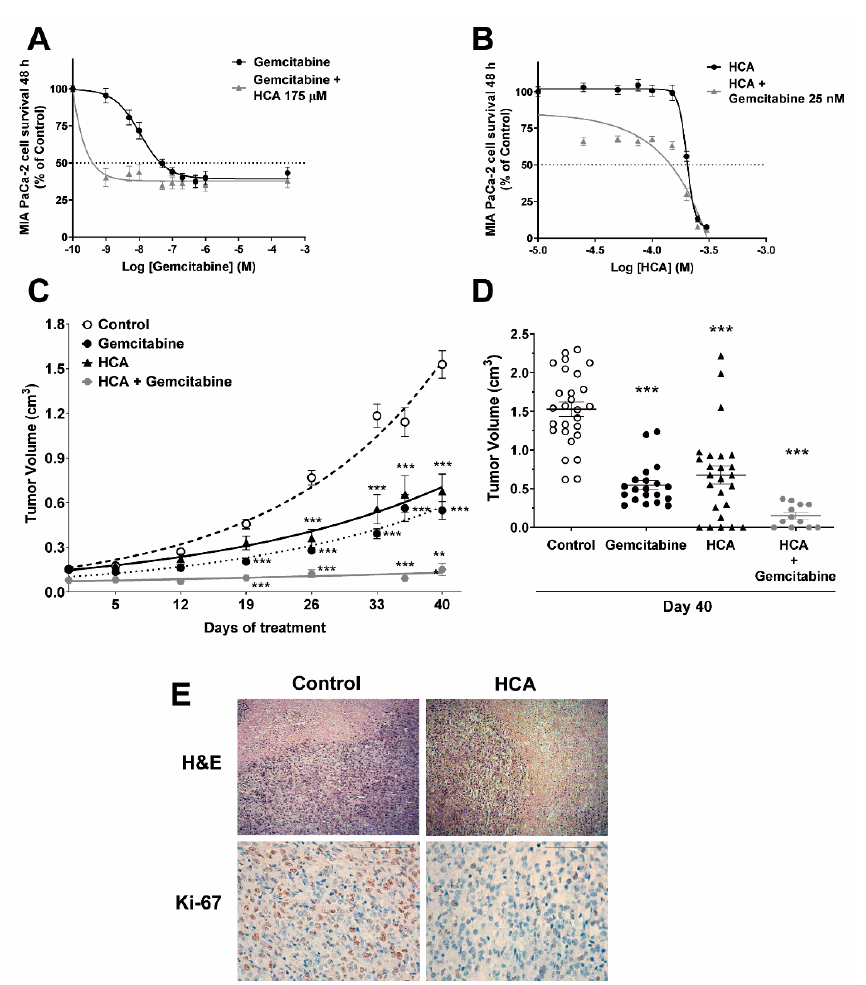
Figure 1. Efficacy of HCA against pancreatic cancer. ( A ) Concentration-dependent inhibition of human pancreatic cell (MIA PaCa-2) growth by gemcitabine and gemcitabine in combination with HCA (175 µM) over 48 h. ( B ) Concentration-dependent inhibition of human pancreatic cell (MIA PaCa-2) growth by HCA and HCA in combination with gemcitabine (25 nM) for 48 h (mean ± SEM from 3 independent experiments performed in quadruplet). ( C ) Effects of the vehicle alone (control), gemcitabine (100 mg/kg, i.p., twice weekly), HCA (200 mg/kg, p.o., daily), or HCA + gemcitabine (100 mg/kg, p.o., daily + 100 mg/kg, i.p., once weekly) on MIA PaCa-2-derived tumor growth in mice over 40 days. ( D ) Tumor volumes after a 40-day treatment (mean ± SEM): control, 27 tumors ( n = 18, 8 males and 10 females); gemcitabine, 20 tumors ( n = 15, 4 males and 11 females); HCA, 25 tumors ( n = 17, 6 males and 11 females); and HCA + gemcitabine, 12 tumors ( n = 6, 2 males and 4 females). ( E ) Histopathological analysis of the tumors obtained from vehicle and HCA- treated animals (40 × magnification). Student’s t -test: * < p 0.05, ** p < 0.01, *** p < 0.001 with respect to the controls. HCA, 2-hydroxycervonic acid; H&E, hematoxylin and eosin; Ki-67, protein proliferation